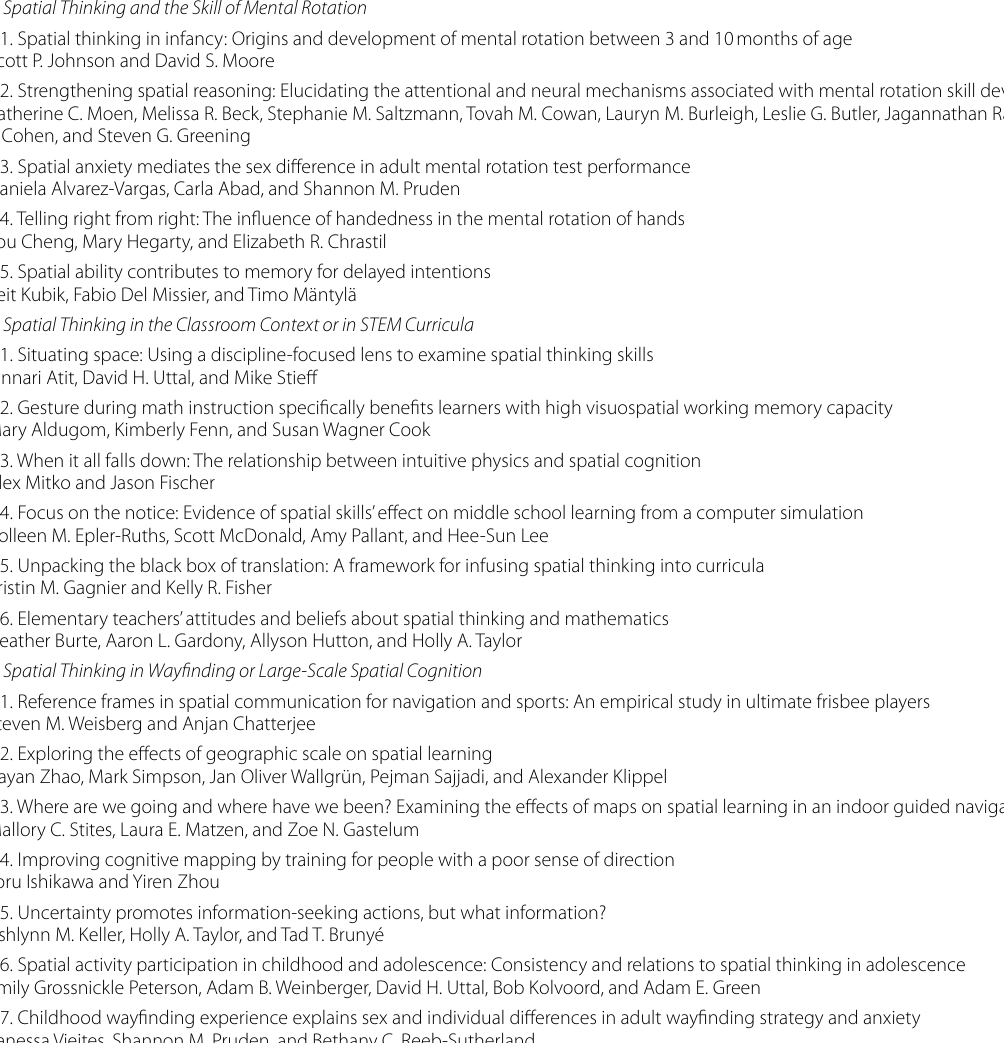
Table 1 Papers in this special issue 1. Spatial Thinking and the Skill of Mental